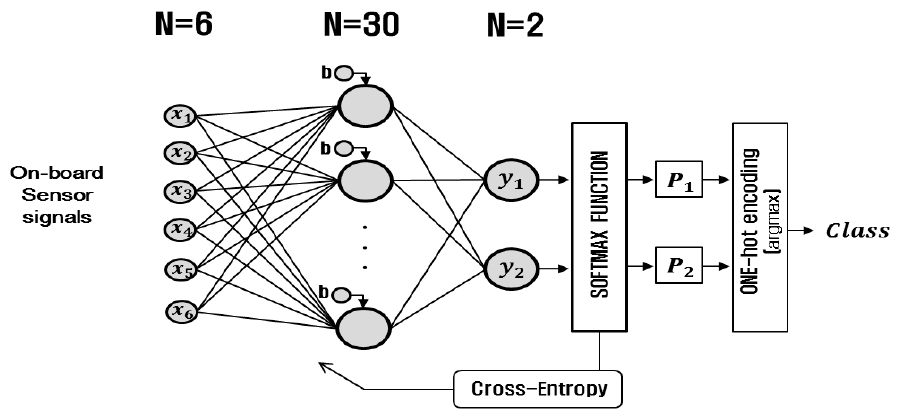
Figure 4. Artificial neural network model for road condition classification module.